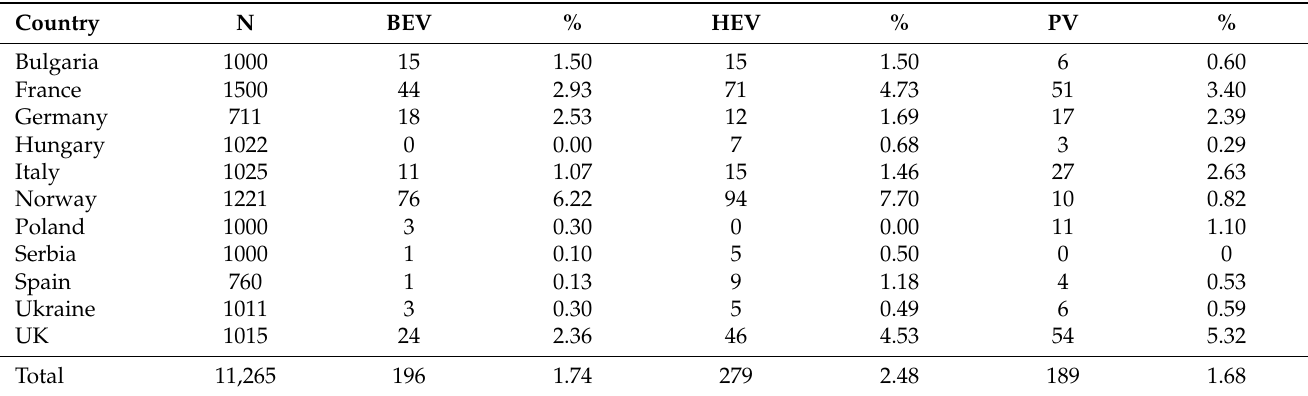
Table 1. Share of electric vehicle and solar